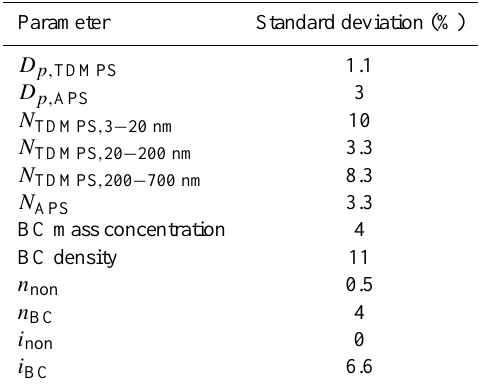
Table 4. Uncertainties of the input parameters for the model, given in terms of one standard